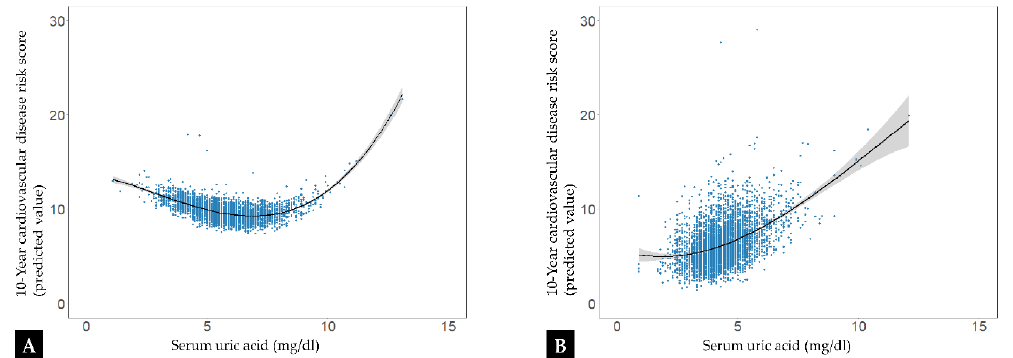
Figure 2. Associations of serum uric acid with cardiovascular disease risk (adjusted for aerobic physical activity, muscular strength exercise, body mass index, serum creatinine, and alcohol consumption) in men ( A ) and women ( B ).